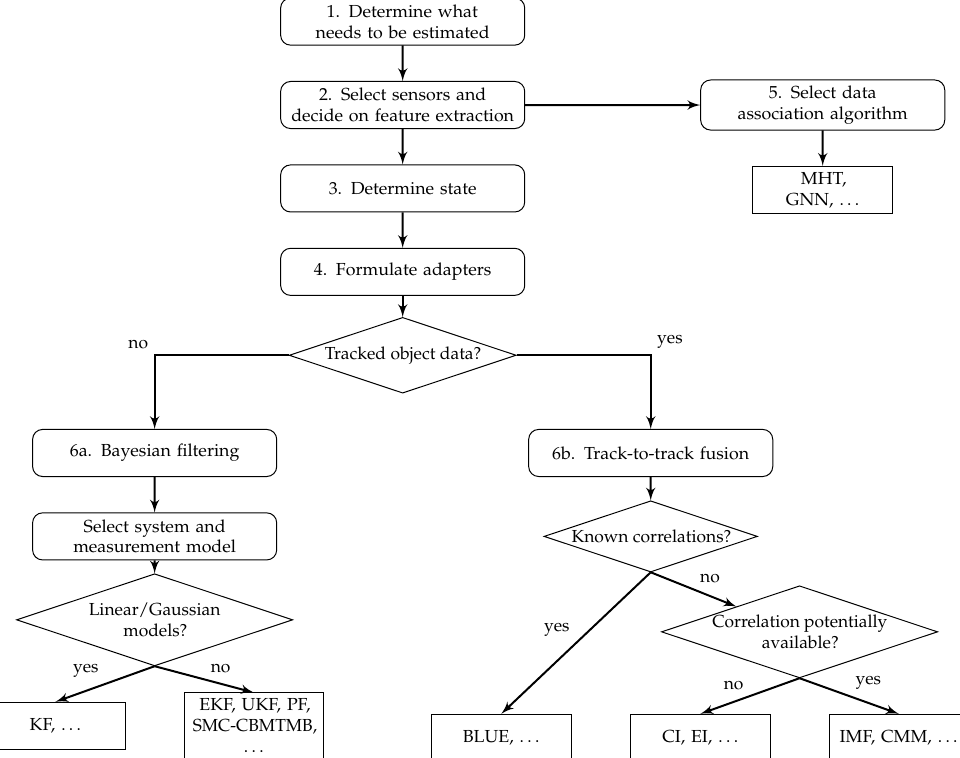
Figure 2. Block diagram showing the various steps in the proposed methodology. PF, Particle Filter; SMC-CBMTMB, Sequential Monte Carlo implementation of the Cardinality-Balanced Multi-Target Multi-Bernoulli; CI, Covariance Intersection; EI, Ellipsoidal Intersection; BLUE, Best Linear Unbiased Estimate; MHT, Multiple Hypothesis Tracking; GNN, Global Nearest Neighbor.